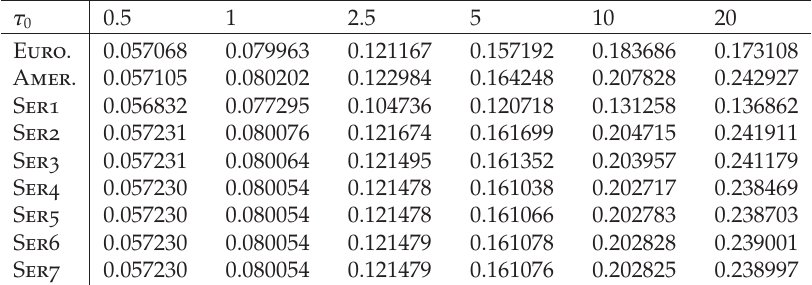
Table 2.3 . Call: Run 3; as in Table 2.1 but S D